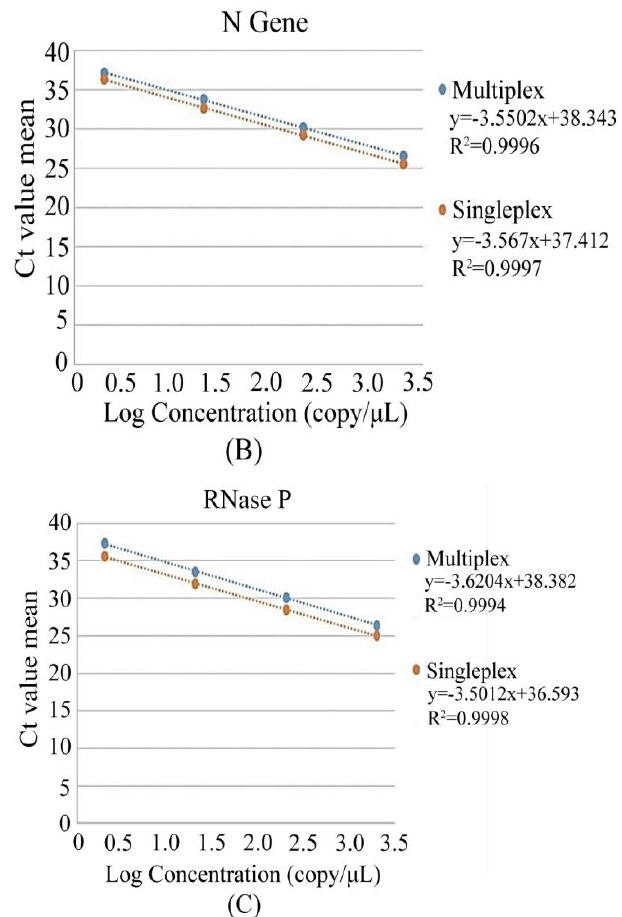
Figure 2. Calculation of calibration curves through singleplex and multiplex rRT-PCR for different copies of positive controls of E , N2 and RNase P . ( A ) Standard curve for E , ( B ) Standard curve for N and ( C ) Standard curve for RNase P .